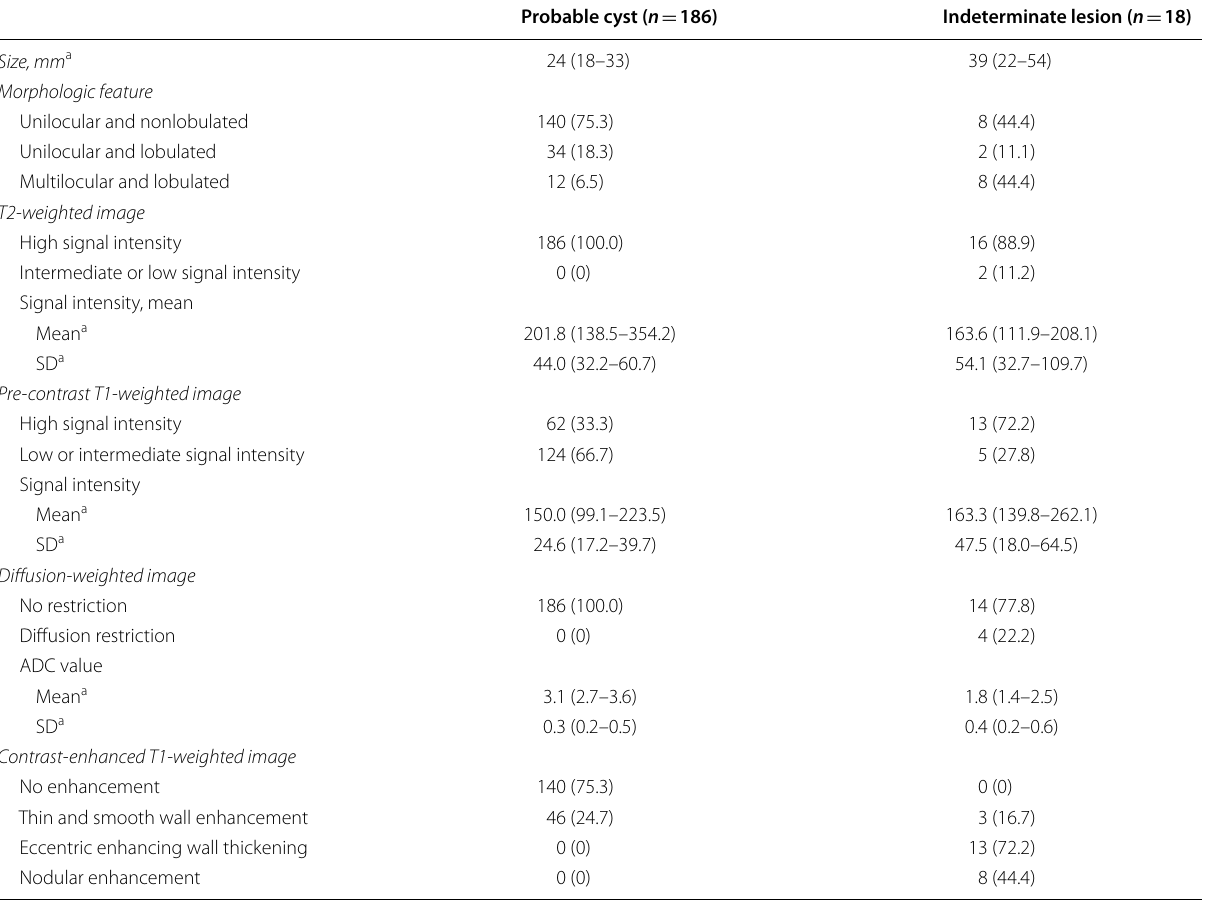
Unless indicated otherwise, data are percentages in parentheses a Data are median with interquartile ranges in parentheses ADC apparent diffusion coefficient, SD standard